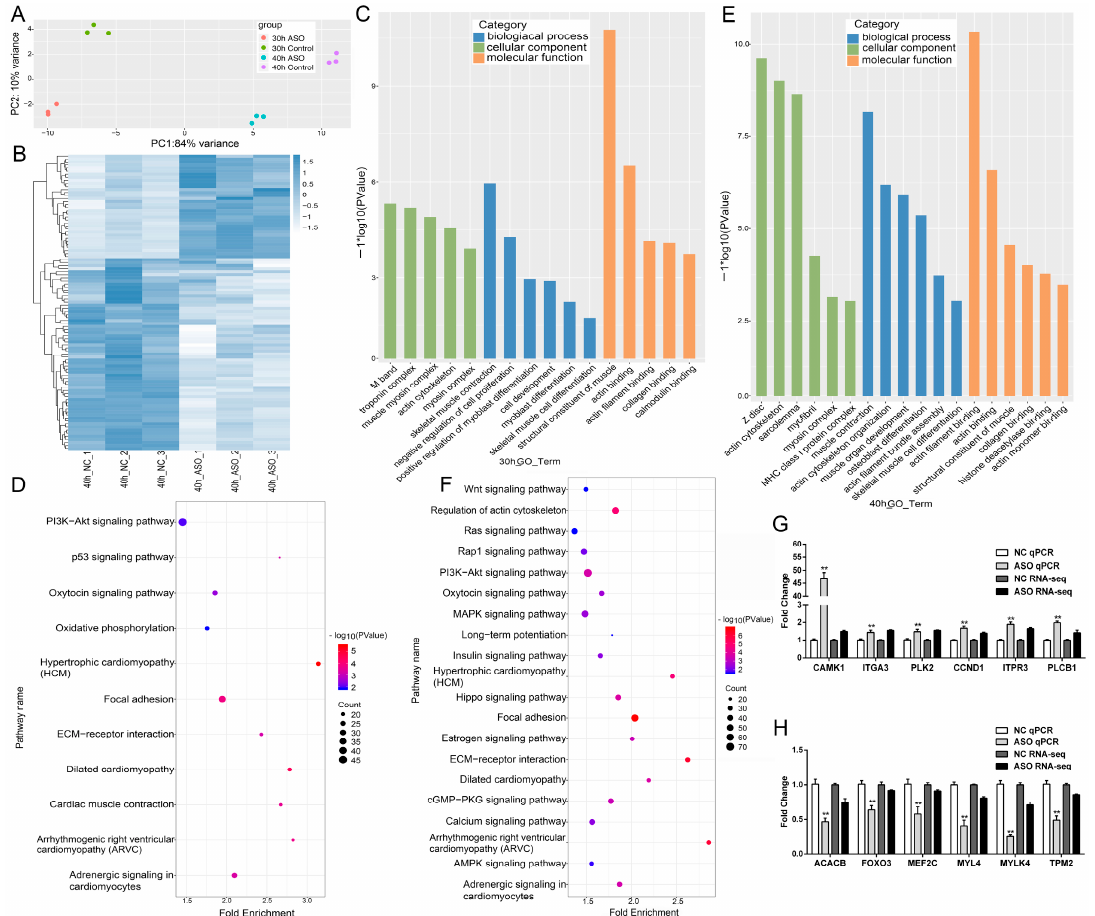
Figure 4. Effect of MEG3 downregulation on myogenesis transcriptome. ( A ) PCA analysis of four datasets (30 hNC, 30 hASO and 40 hNC, 40 hASO groups) for MEG3 knockdown. ( B ) Hierarchical clustering of differentially expressed genes after transfection of porcine satellite cells with ASO– MEG3 or ASO–NC and differentiation for 40 h. The color-ratio bar at the right indicates intensity of gene upregulation (blue) and downregulation (white). ( C – F ) GO enrichment and KEGG pathway scatterplot analysis for differentially expressed genes for cells differentiated for 30 ( C , E ) and 40 h ( D , F ). ( G , H ) Validation of differentially expressed genes involved in muscle development by qPCR. The y -axis indicates the fold change of RNA-Seq and qPCR. The relative mRNA levels were normalized to those of the control 18S rRNA . Error bars represent mean ± SEM of three biological replicates. Statistical significance of differences was assessed by Student’s t -test. ** p < 0.01. NC, negative control. ASO, antisense oligonucleotide. PCA, Principal component analysis. GO, Gene ontology. KEGG, Kyoto Encyclopedia of Genes and Genomes. qPCR, quantitative polymerase chain reaction.